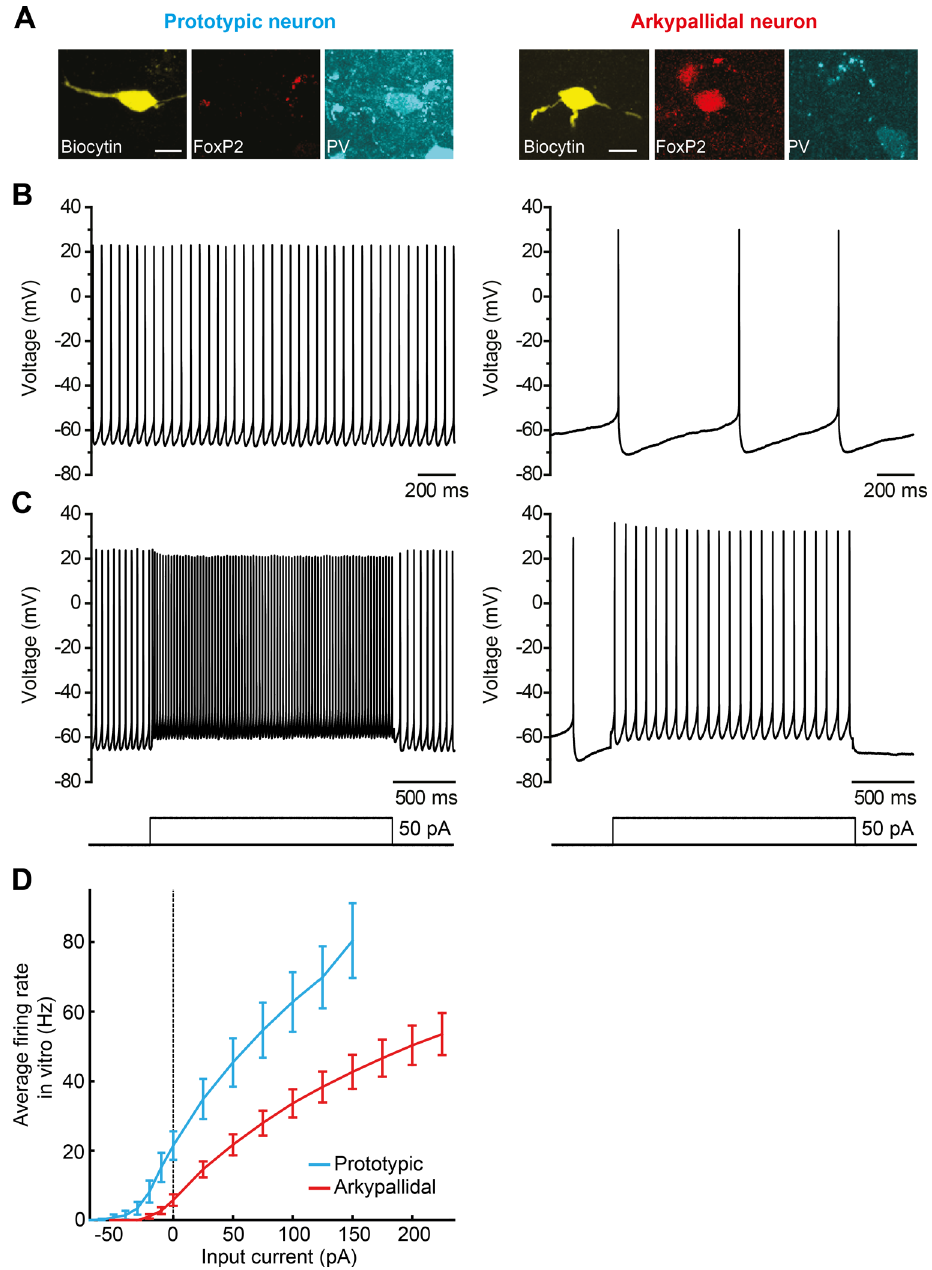
Fig 3. Autonomous firing and driven responses of molecularly-identified GPe neurons. (A) After recording, all neurons were labelled with biocytin, recovered and tested for expression of parvalbumin (PV) and forkhead box protein 2 (FoxP2). Prototypic GPe neurons (left) expressed PV but not FoxP2, whereas arkypallidal neurons (right) expressed FoxP2 but not PV. Scale bars = 20 μ m. (B) Typical examples of the autonomous firing of a prototypic neuron (left) and an arkypallidal neuron (right). (C) Typical examples of the driven activity of a prototypic neuron (left) and arkypallidal neuron (right). Same neurons as shown in A and B. (D) Average f-I curves of prototypic and arkypallidal neurons recorded in vitro . The error bars show the standard error of the mean.